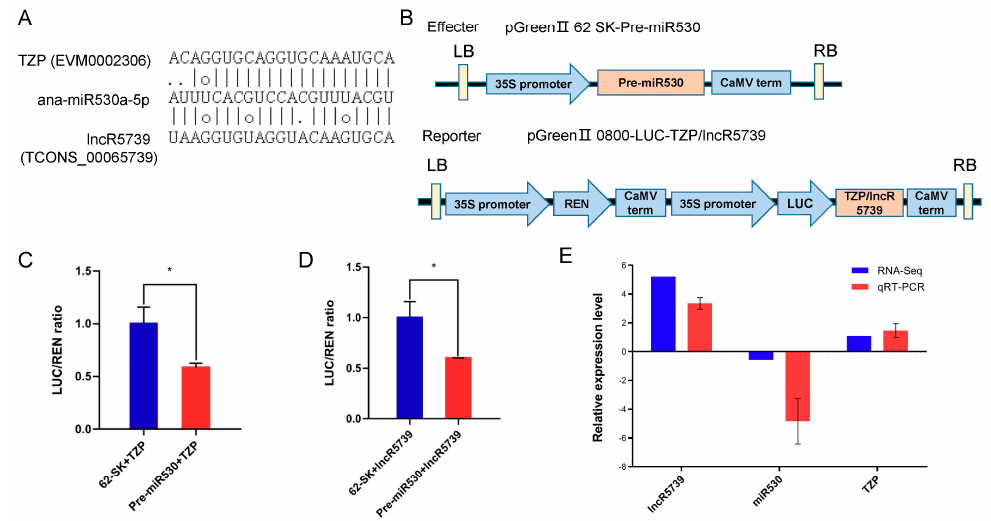
Figure 10. Dual-luciferase reporter assay demonstrates that the lncR5739 and TZP gene is targeted by miR530 . ( A ) Binding sites of miR530 on lncR5739 and TZP as predicted by psRNA target. ( B ) Dual-luciferase reporter vector construction. ( C ) The ratio of LUC/REN in the 62 SK + TZP and pre-miR530 + TZP cells. ( D ) The ratio of LUC/REN in the 62 SK + lncR5739 and pre-miR530 + lncR5739 cells. ( E ) Values are expressed as means ± SD ( n = 3), and the statistically significant differences were evaluated using Student’s t -test, * p < 0.05. qRT-PCR analysis of the lncR5739 , TZP , and miR530 . The y -axis shows the relative expression with U6 or actin as the internal reference. Data are averaged over three technical replicates.